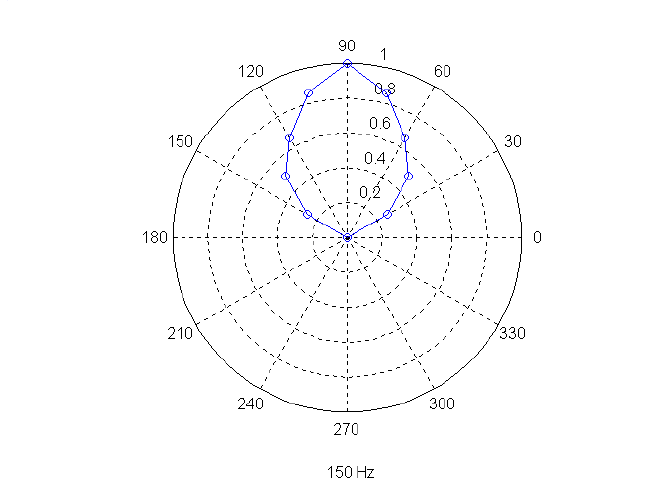
Figure 14. Experimentally obtained polar diagram of a 150 Hz resonant